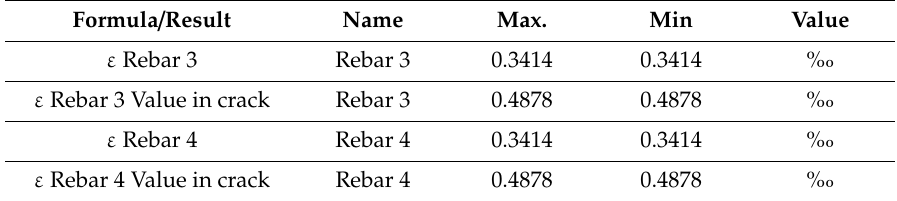
Table 2. Deformation of the rebars 3 and 4 for a moment of 31.68 mkN by FAGUS.